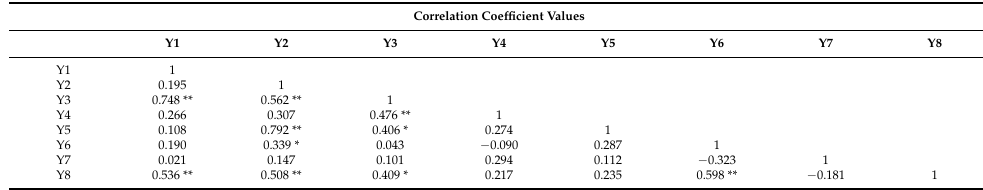
Table 1. Correlation coefficient values for the pairs of studied characters in three grapevine cultivars under cold